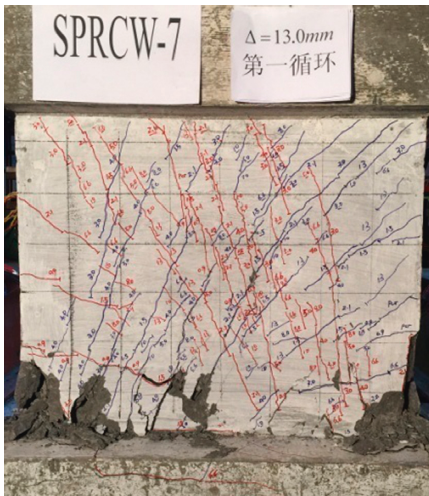
Figure 9: Failure mode of SPRCW-7.